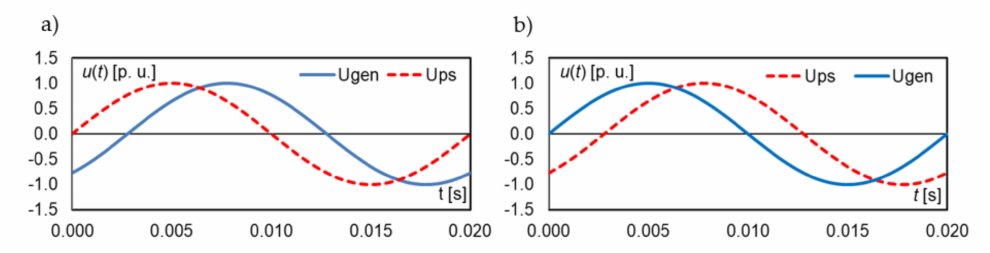
Figure 4. Two cases of voltage waveforms during faulty synchronization: ( a ) power system voltage ( U PS ) lagging with respect to generator voltage ( U GEN ); ( b ) power system voltage leading with respect to generator voltage.